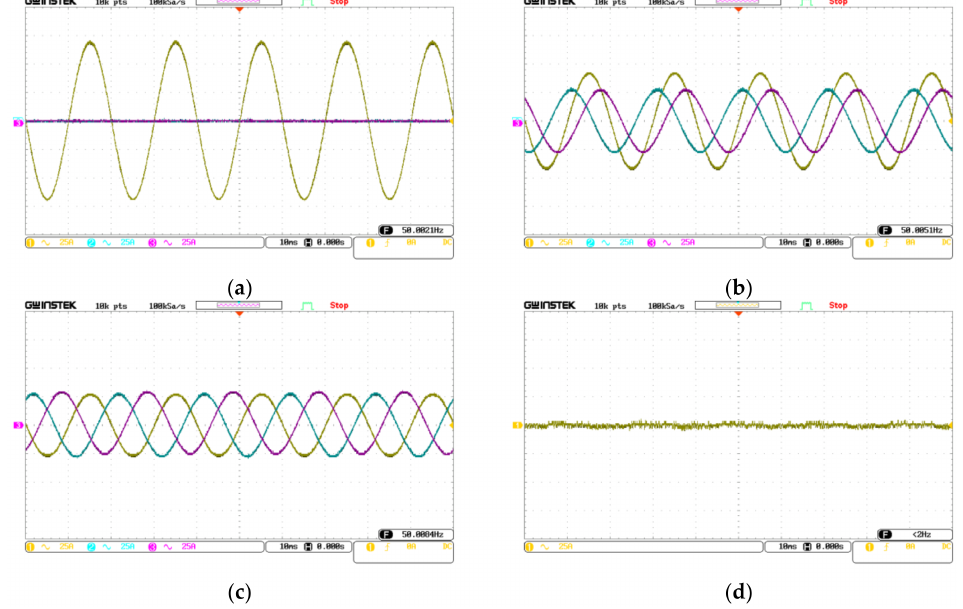
Figure 23. Steady state experimental waveform of unbalanced load compensation: ( a ) Three-phase unbalanced load current; ( b ) Three-phase output current of SPC; ( c ) Three-phase grid current; ( d ) Zero line